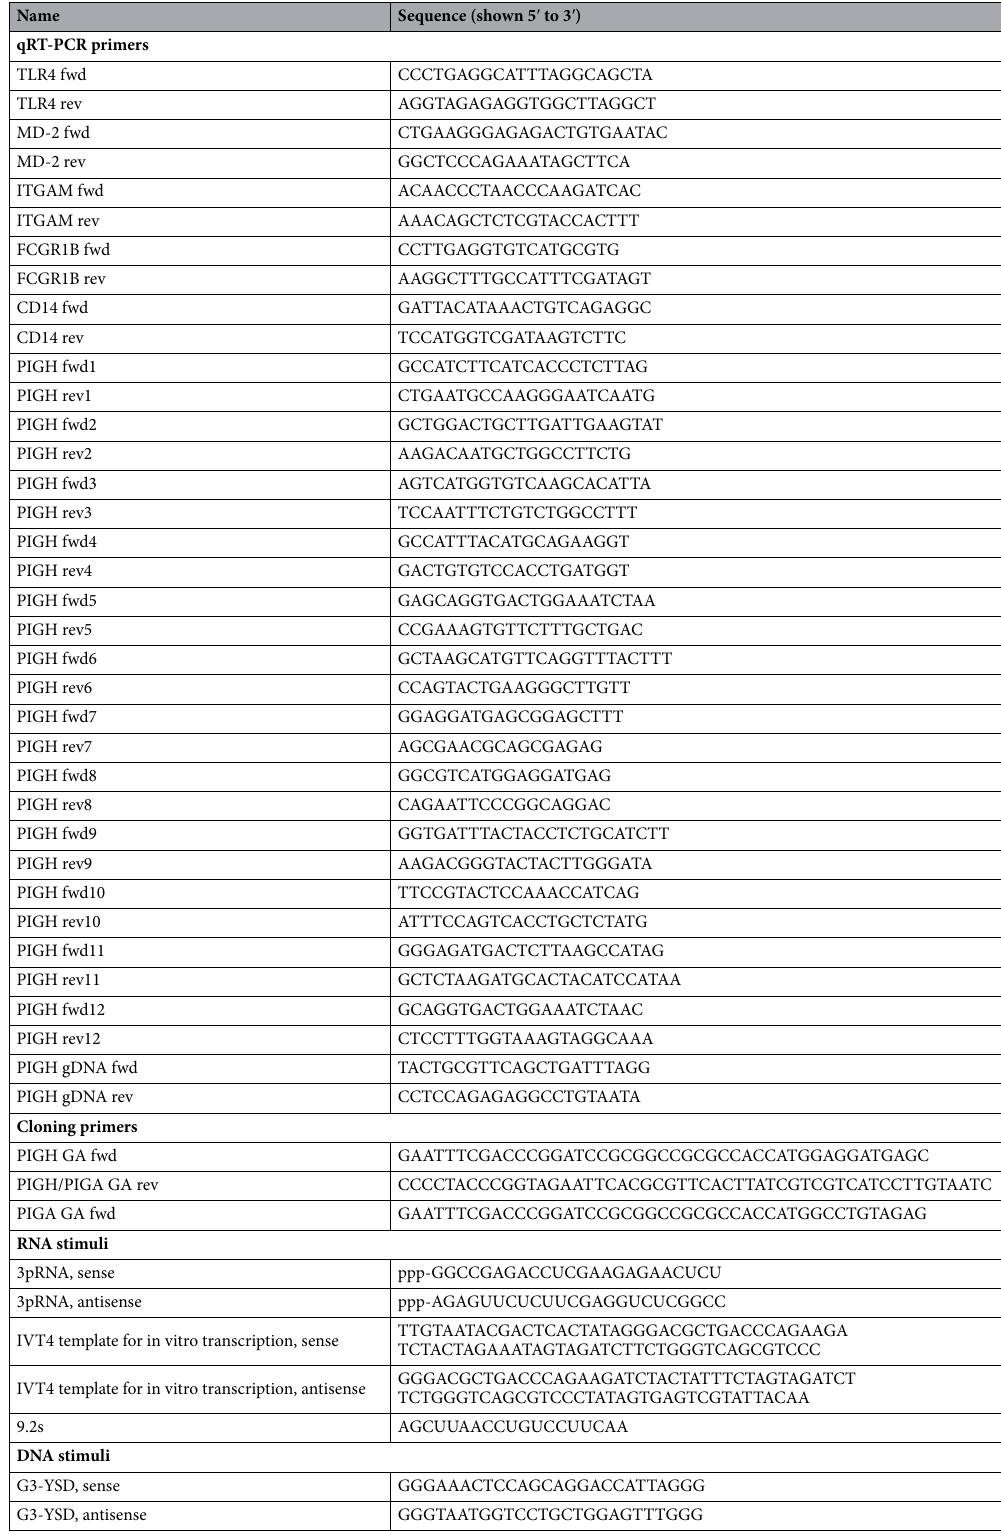
Table 1. DNA and RNA oligonucleotide sequences. The sequences of DNA and RNA oligonucleotides used for qRT-PCR, cloning and cell stimulation are